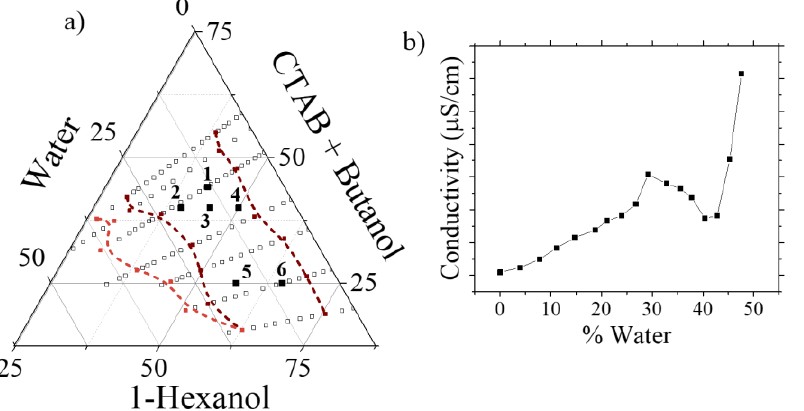
Figure 1. ( a ) Ternary diagram of the CTAB-butanol–hexanol–water system showing the composition of the different microemulsions used for the synthesis of the SPIONs, denoted as 1, 2, 3, 4, 5 and 6, all of them within the microemulsion stability region. ( b ) Conductivity measurements as a function of the water content for the point 6 in the CTAB-butanol-hexanol microemulsion system.